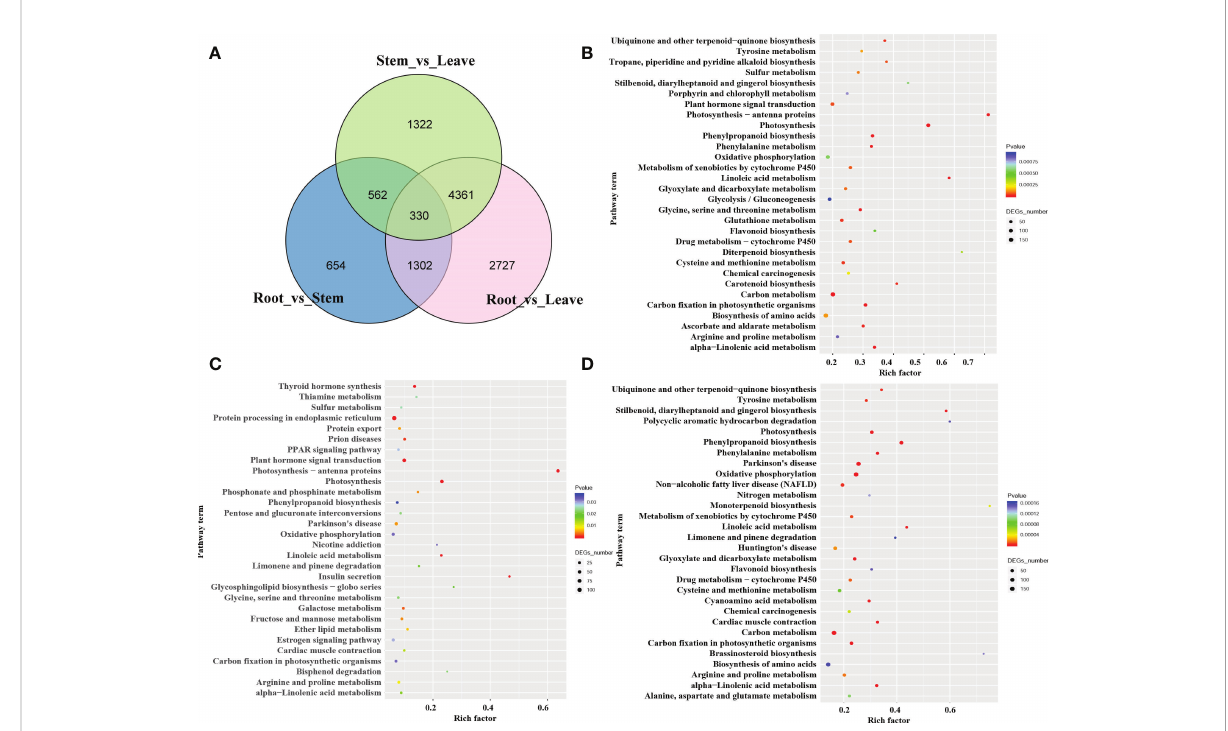
FIGURE 3 The number and pathway terms of differentially expressed genes among the root, stem, and leaf. (A) Venn diagram of DEGs in the three tissues. (B) , (C) : pathway enrichment of genes predominantly expressed in the root (B) , stem (C) , and leaf (D)